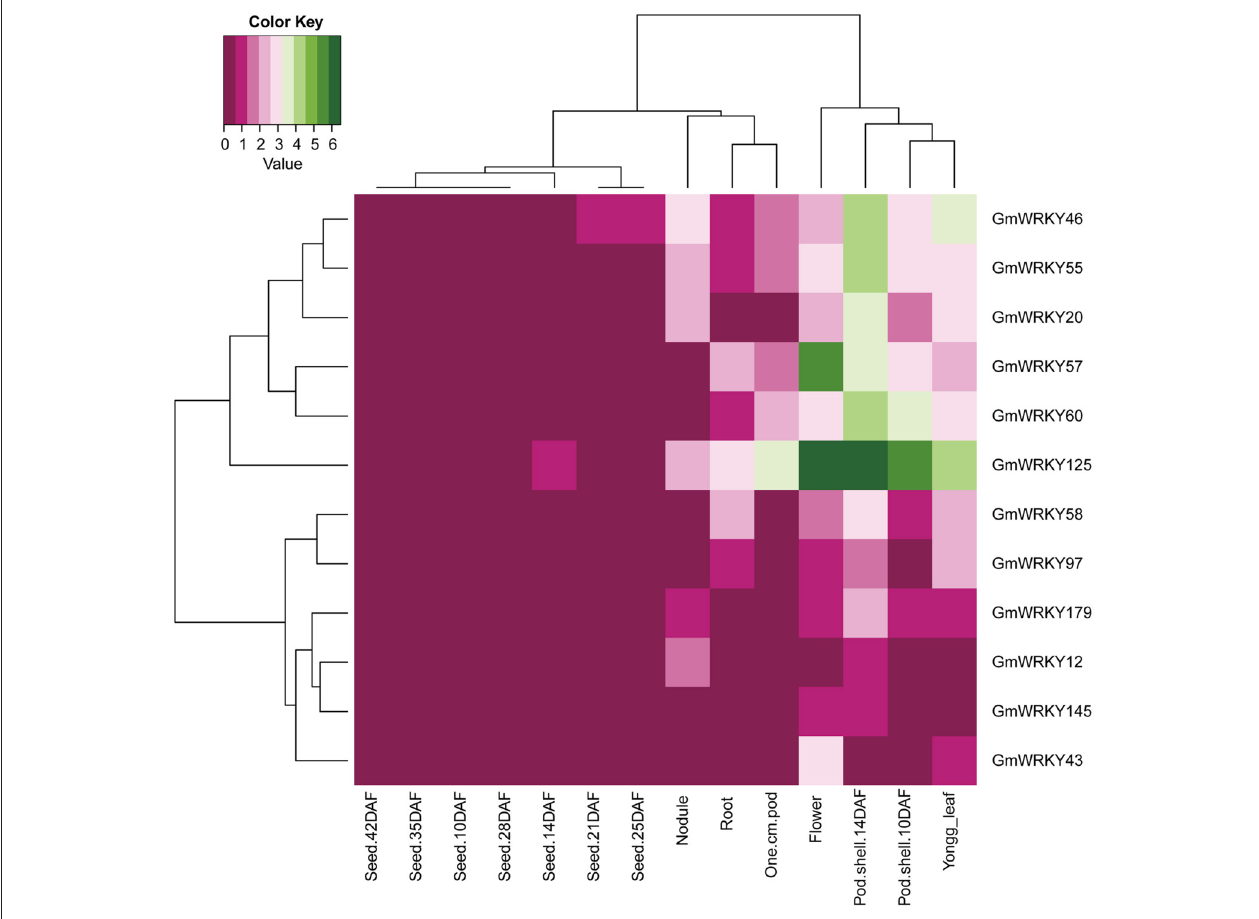
FIGURE 7 | Expression pattern of GmWRKY group III genes in different tissues. The Reads/Kb/Million (RPKM) normalized values of expressed genes was log 2 -transformed. The abbreviation “DAF” in the tissue label indicates “Days after